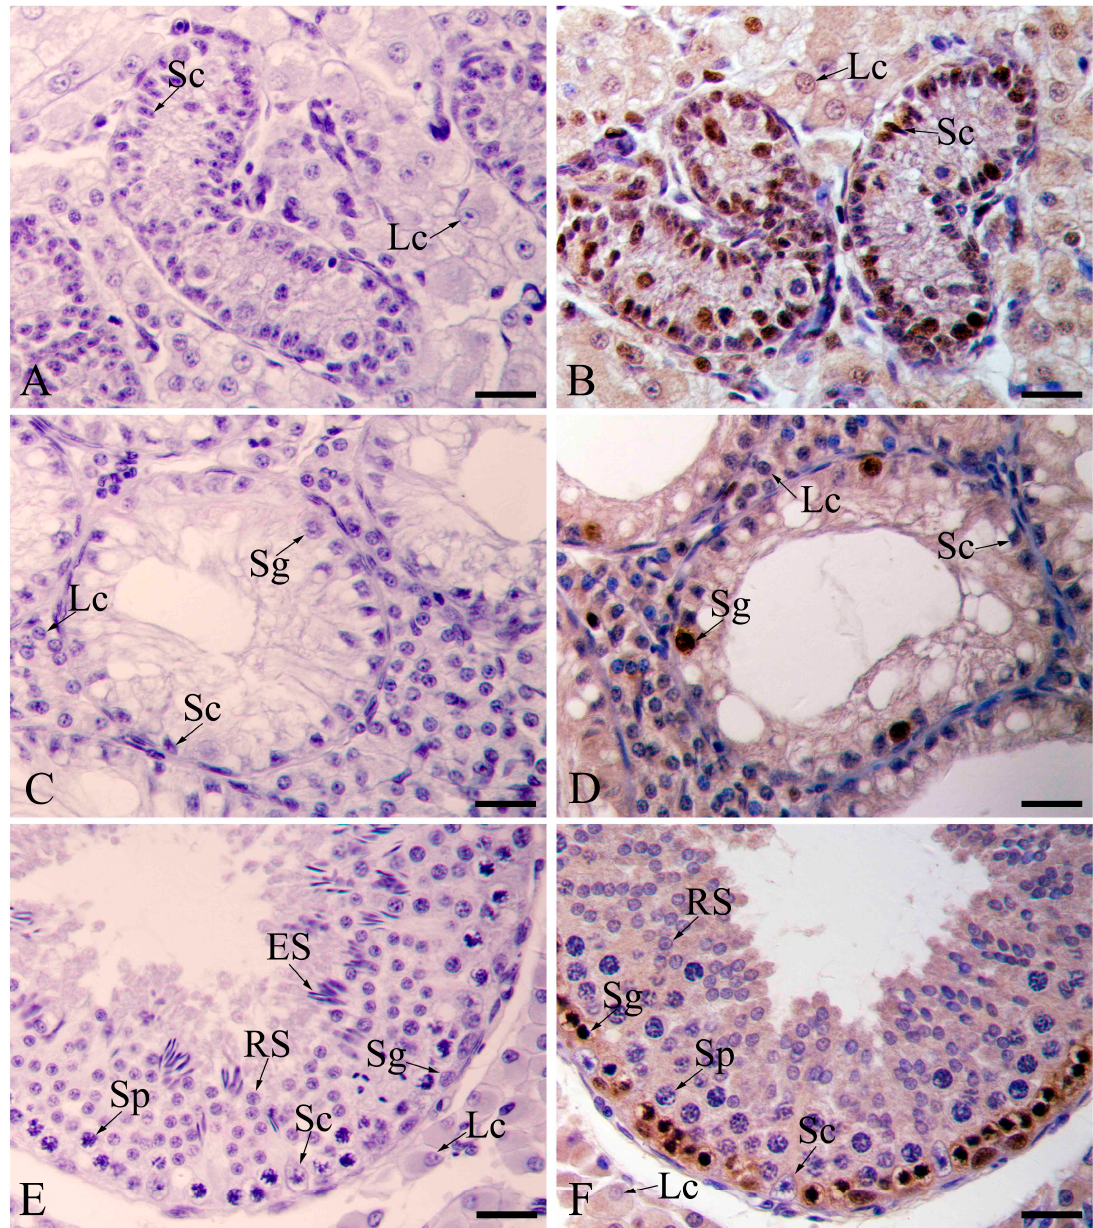
Figure 5. Immunohistochemical staining of PCNA in seminiferous tubules of boar testes. PCNA-positive cells in preweaning, cryptorchid, and contrascrotal testes—( B , D , F ), respectively. In the negative control sections of boar testes—( A , C , E )—non-immune rabbit serum was substituted for the primary antibody in the first reaction. Note the lack of immunoreactivity. Sg, spermatogonia; Sp, spermatocyte; RS, round spermatid; ES, elongated spermatid; Sc, Sertoli cell; Lc, Leydig cell. Bar = 25 μ m.